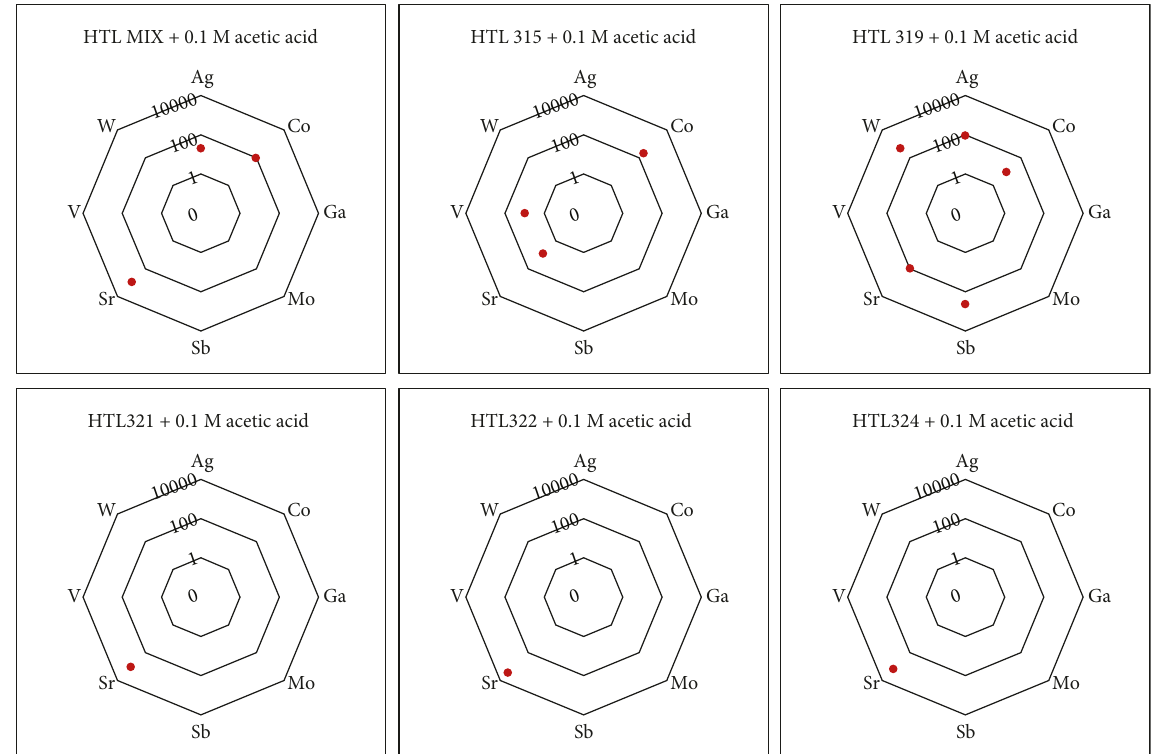
Figure 16: The amount of “ at risk ” elements in leachate samples reacted with 0.1M acetic acid at 250 ° C temperature under 250 bar pressure in ppb after 36, 37, 42, 27, 38, and 48 minutes, respectively (absence of data points re fl ects concentrations below the limits of